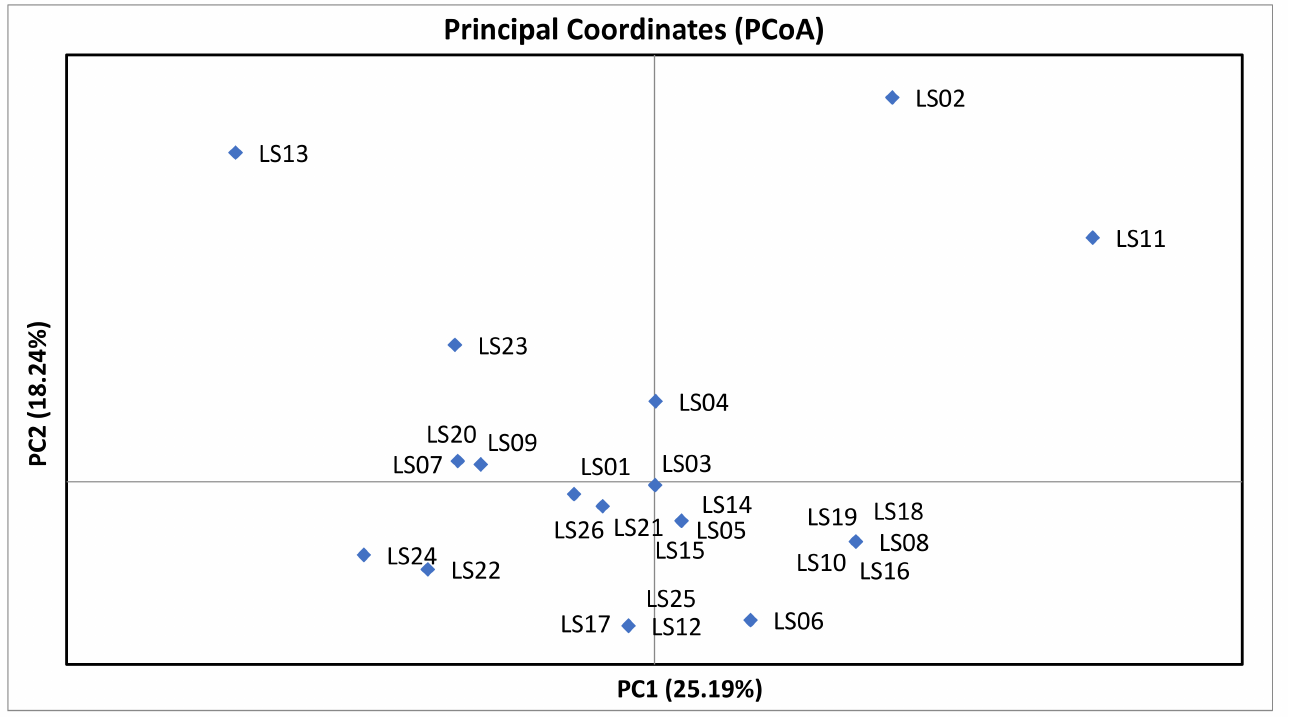
Figure 1. Principal coordinate analysis (PCoA) based on 9 polymorphic SSR markers and 26 okra accessions (coded LS01 to LS26, Table 1). Note PC1 denotes the first principal coordinate and PC2 the second principal